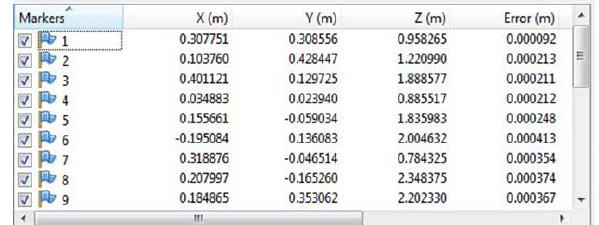
Figure 8. Re-projection errors on targets of the optimised model in Agisoft